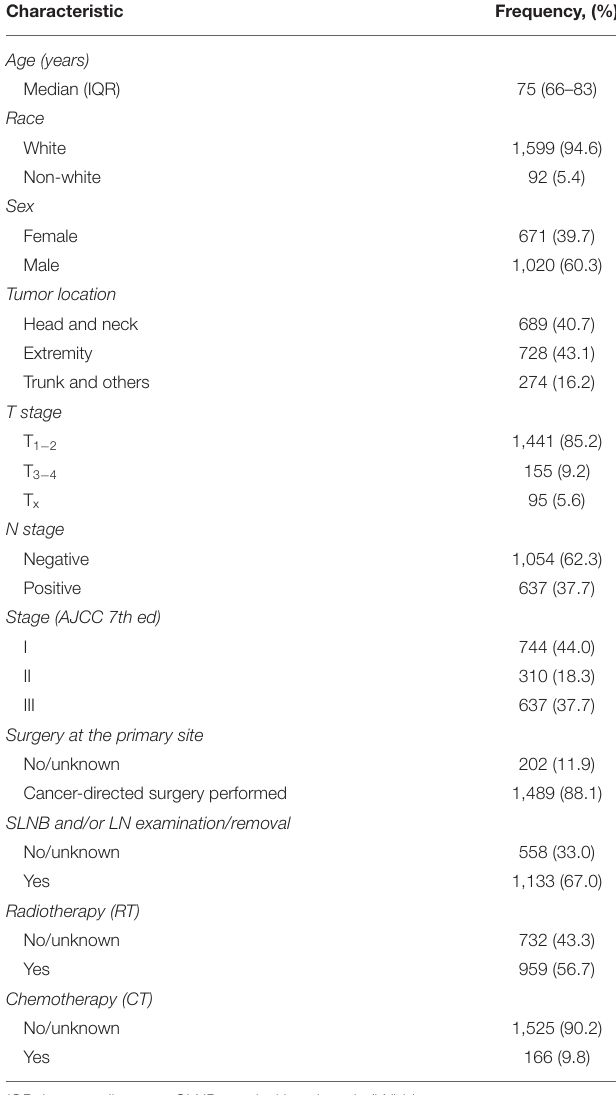
TABLE 1 | Baseline characteristics of stage I-III MCC